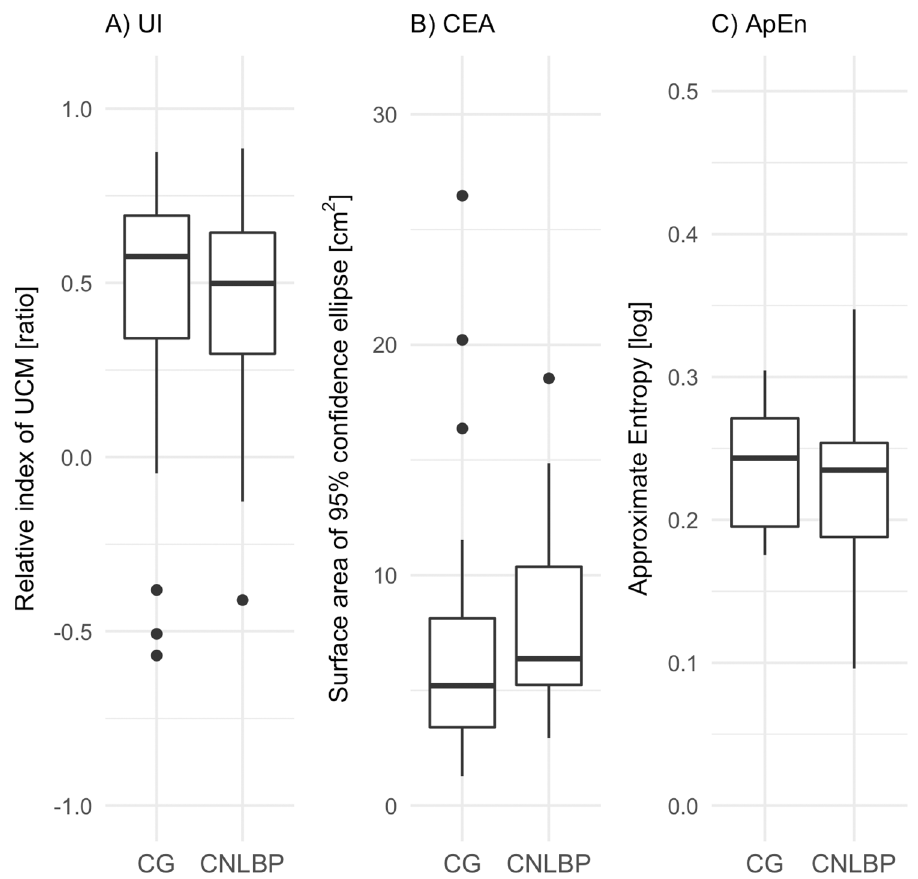
Fig 4. Group comparison of postural outcome measures. Across trials mean values of primary outcomes during active response phase after platform release. CG = control group; CNLBP = Chronic non-specific low back pain group; UI = Uncontrolled Manifold Index; CEA = 95% confidence ellipse surface area; ApEn = approximate entropy of antero-posterior centre of pressure signal.